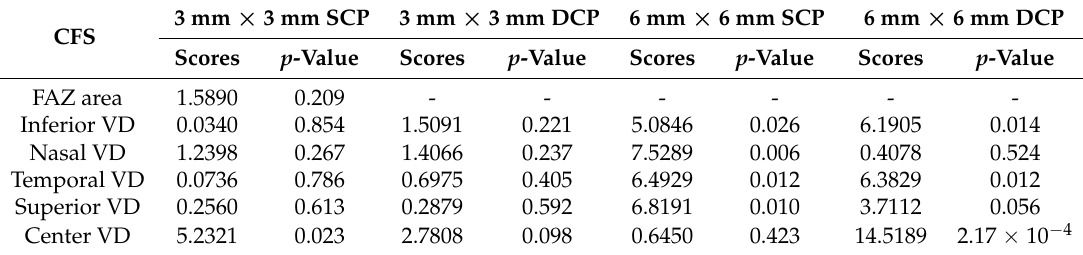
Table 3. Correlation Feature Selection (CFS) application over the used dataset, obtaining as a result the score of each feature in the regression problem, as well as their reliability p